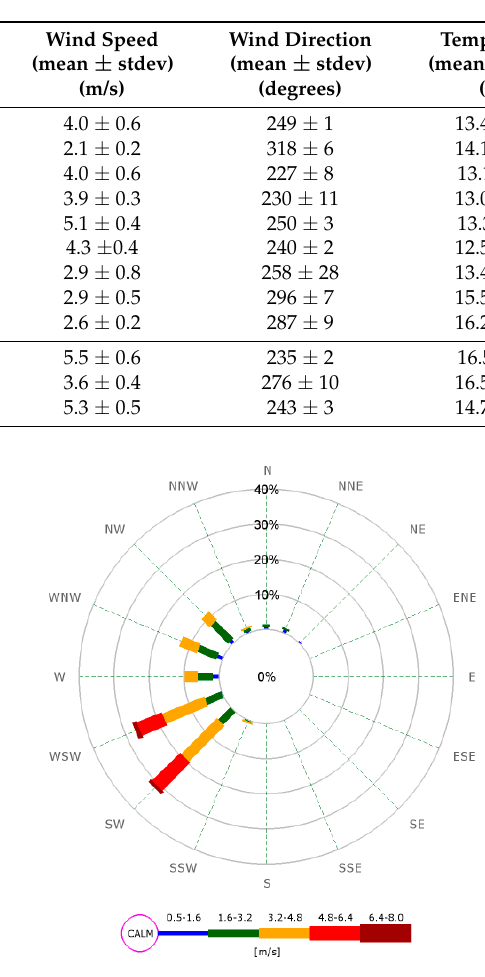
Table 2. Key meteorological data including means and standard deviations obtained from the Penrose air quality monitoring station situated just over 3 km to the south of the experimental site. The values are based on the three 10-min average observations made closest to the commute time (7:50–8:10 am and 3:10–3:30 pm).